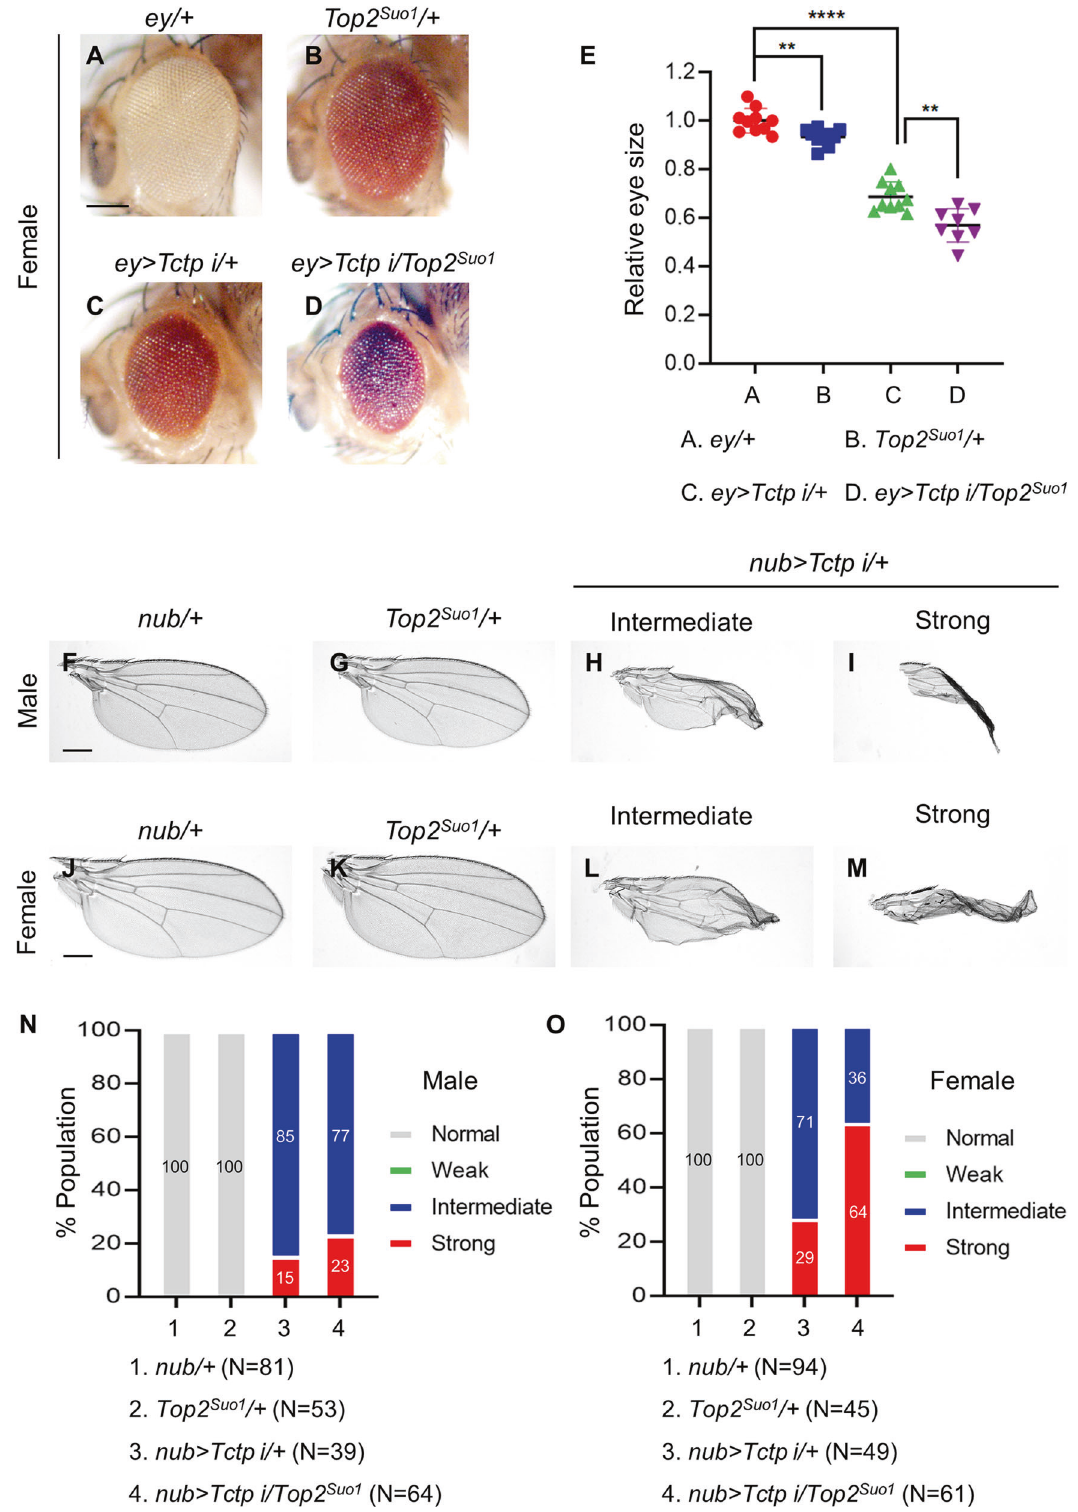
Fig. 4 Top2 shows genetic interaction with Tctp in organ growth. A – D Top2 Suo1 / + enhances Tctp RNAi eye phenotype in females. A ey/ + ( n = 10, x ̅ ± s = 1 ± 0.05), ( B ) Top2 Suo1 / + ( n = 10, x ̅ ± s = 0.933 ± 0.034), ( C ) ey > Tctp RNAi/ + ( n = 10, x ̅ ± s = 0.687 ± 0.06), ( D ) ey > Tctp RNAi/Top2 Suo1 ( n = 8, x ̅ ± s = 0.569 ± 0.069). Scale bar in ( A ) is150 µm. E Quanti fi cation of relative eye sizes in ( A – D ). Statistical analysis in E by unpaired two- tailed student t -test, ** P < 0.01 and **** P < 0.0001. Error bars in ( E ) are SD. F – M Wing phenotypes of Tctp RNAi and Top2 Suo1 / + in males ( F – I ) and females ( J – M ). F , J nub/ + control, ( G , K ) Top2 Suo1 / + , H , L Intermediate phenotype showing wing size reduction, ( I , M ) Strong phenotype showing size reduction with severe folding. Scale bars in ( F ), ( J ) are 300 µm. N , O Genetic interaction between Tctp RNAi and Top2 Suo1 / + in males ( N ) and females ( O ). Top2 Suo1 / + weakly enhances the intermediate phenotype to the strong phenotype in males ( N ) while strongly enhancing it in females ( O ). N number of animals. Cell Death and Disease (2021)